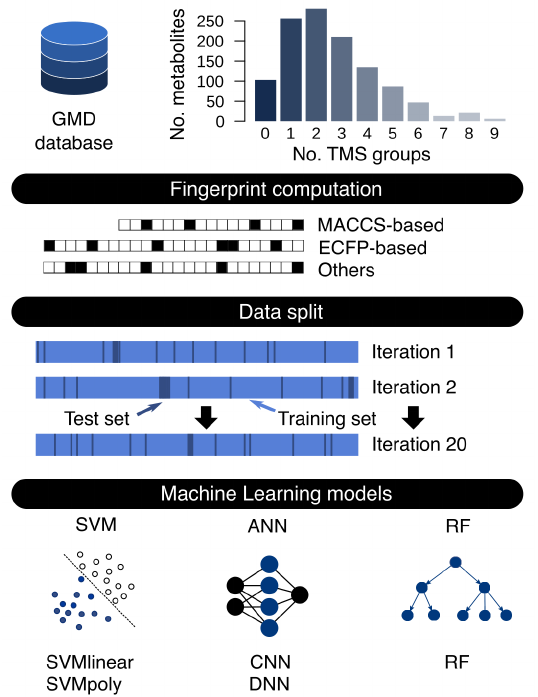
Figure 1. Workflow for RI prediction. The histogram shows the number of TMS groups of metabolites in GMD. Multiple fingerprint classes were generated from metabolites in GMD and metabolites were randomly split in training and test sets generating 20 different sets to train and test the ML